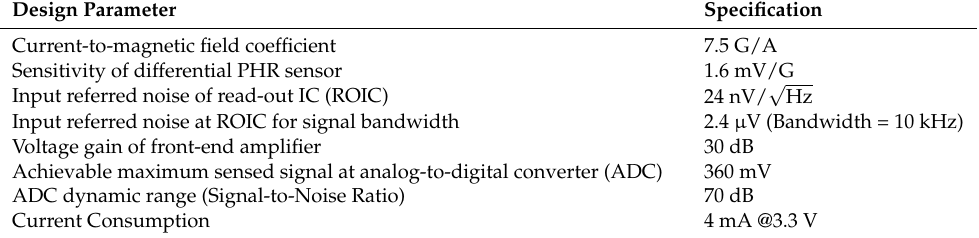
Table 1. Main design parameters in the current sensor.